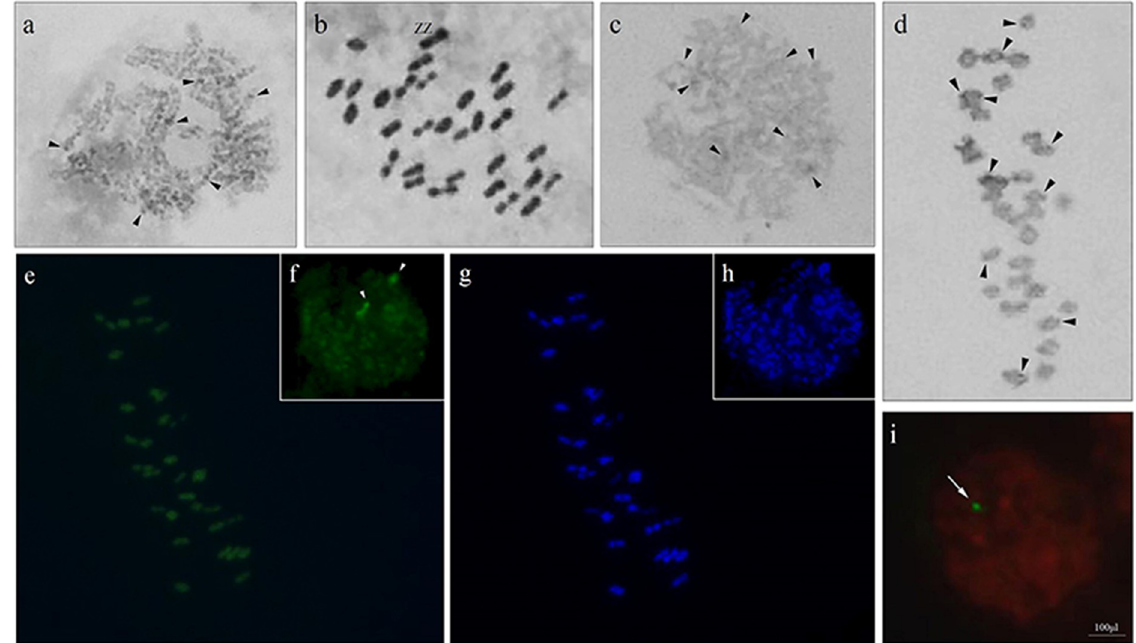
Fig 2. Meiotic cells of C . includens in different staining by Giemsa (a-d) fluorochromes CMA 3 /DAPI (e-h). (a) pachytene; (b) metaphase II; (c) pachytene submitted to the C-banding; (d) metaphase II with C-banding; (e) metaphase II, arrows indicate GC-rich sites; (f) interphase nucleus, the arrowheads indicate the CMA 3+ marks; (g) metaphase II, observe the greatest number of DAPI + marks; (h) interphase nucleus stained with DAPI, observe the AT-rich marks; (i) interphase nucleus after fluorescence in situ hybridization with 18S DNAr probe.